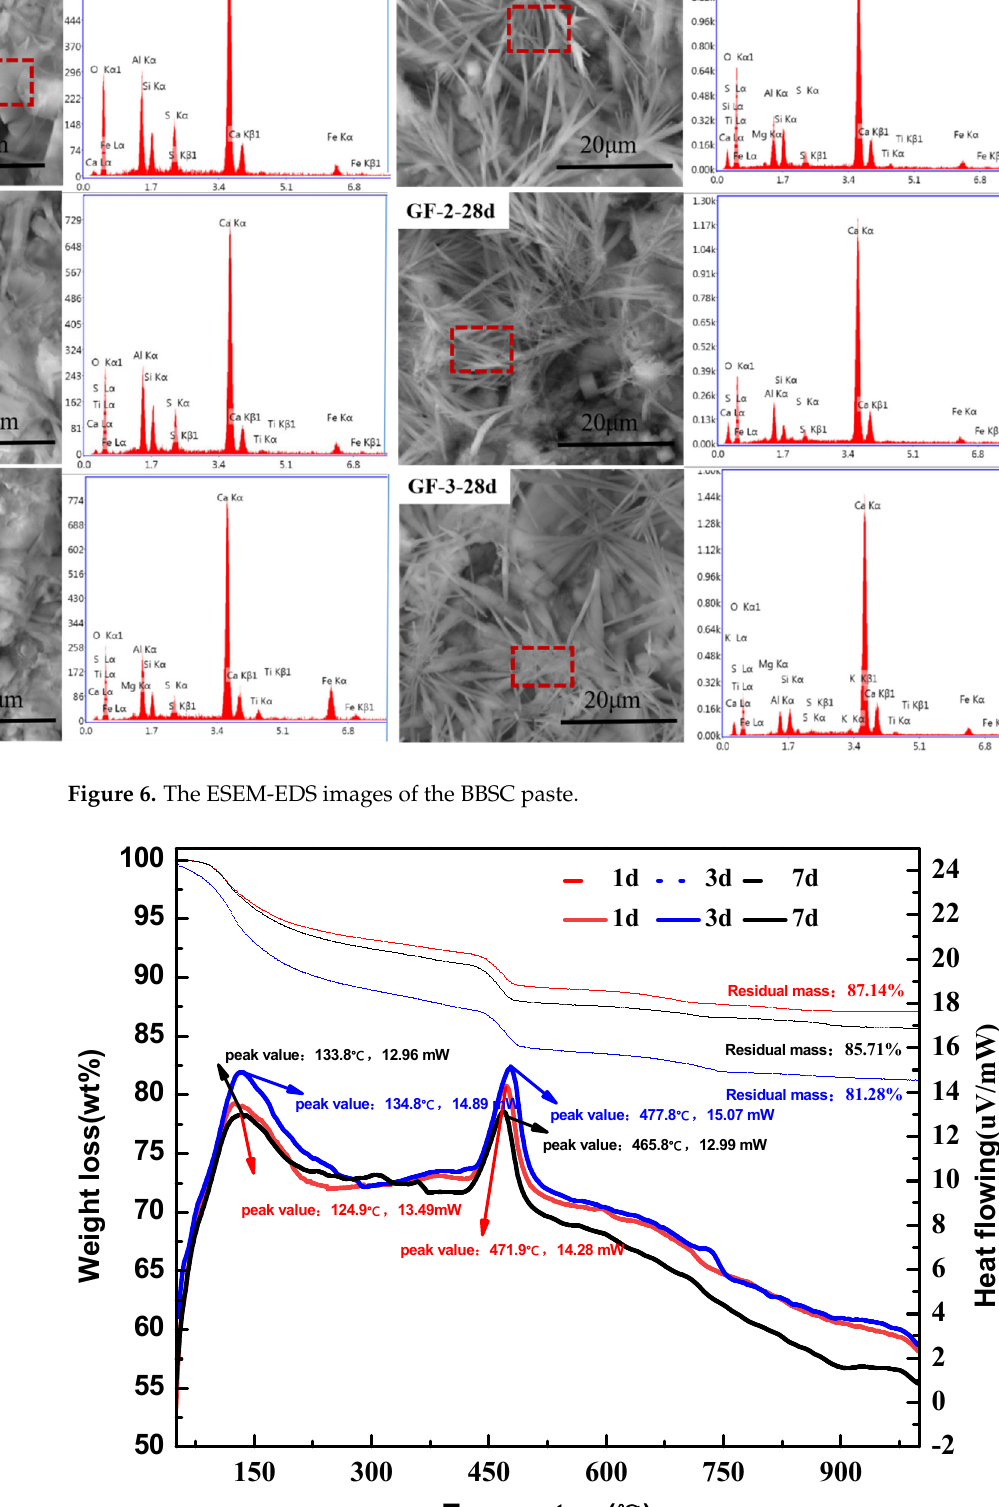
Figure 7. The TG-DSC of sample GF-2.